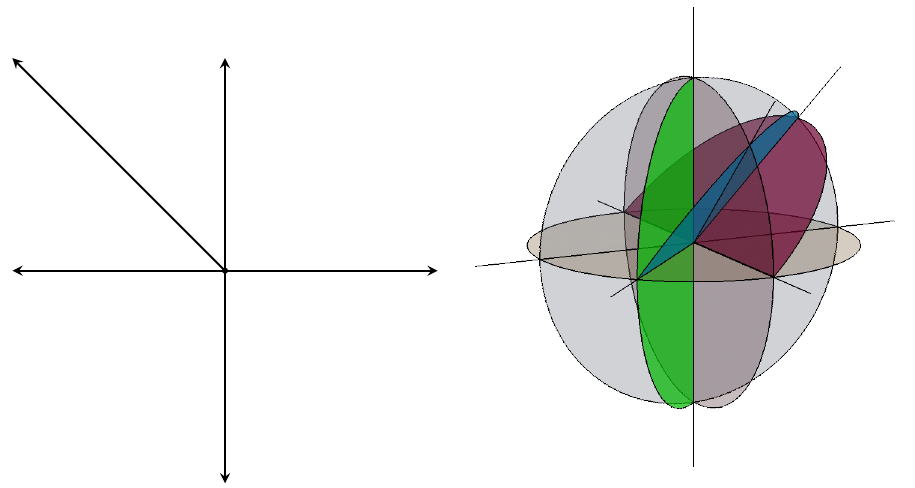
Figure 2. Pictures of the scattering diagrams corresponding to Gr (2 , 5) /T (left) and Gr (2 , 6) /T